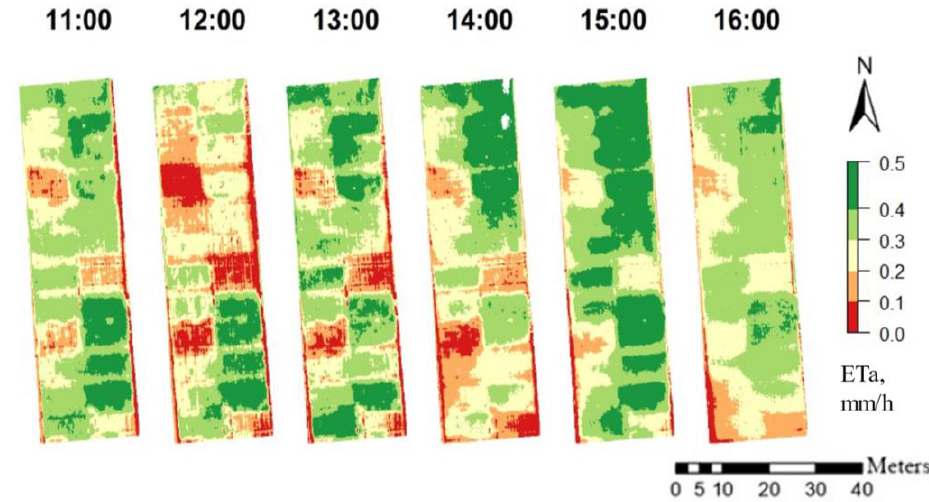
Figure 7. ET a maps of the diurnal flights on 23 April 2020 calculated based on WDI NDVI .